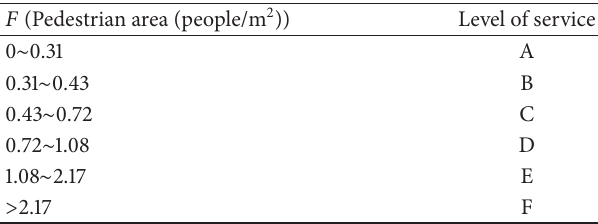
Table 1: Fruin’s level of service evaluation